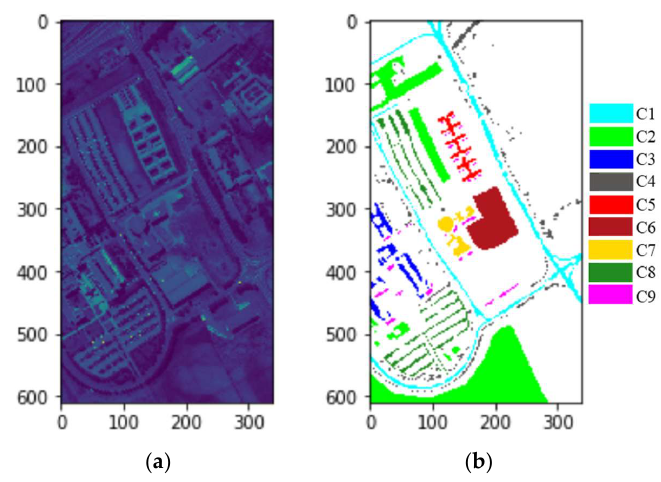
Figure 9. The Pavia University image: ( a ) the 21th band image; ( b ) the ground truth of Salinas, where the white area represents the unlabeled pixels. Table 3. Pavia University image: the number of samples per class.